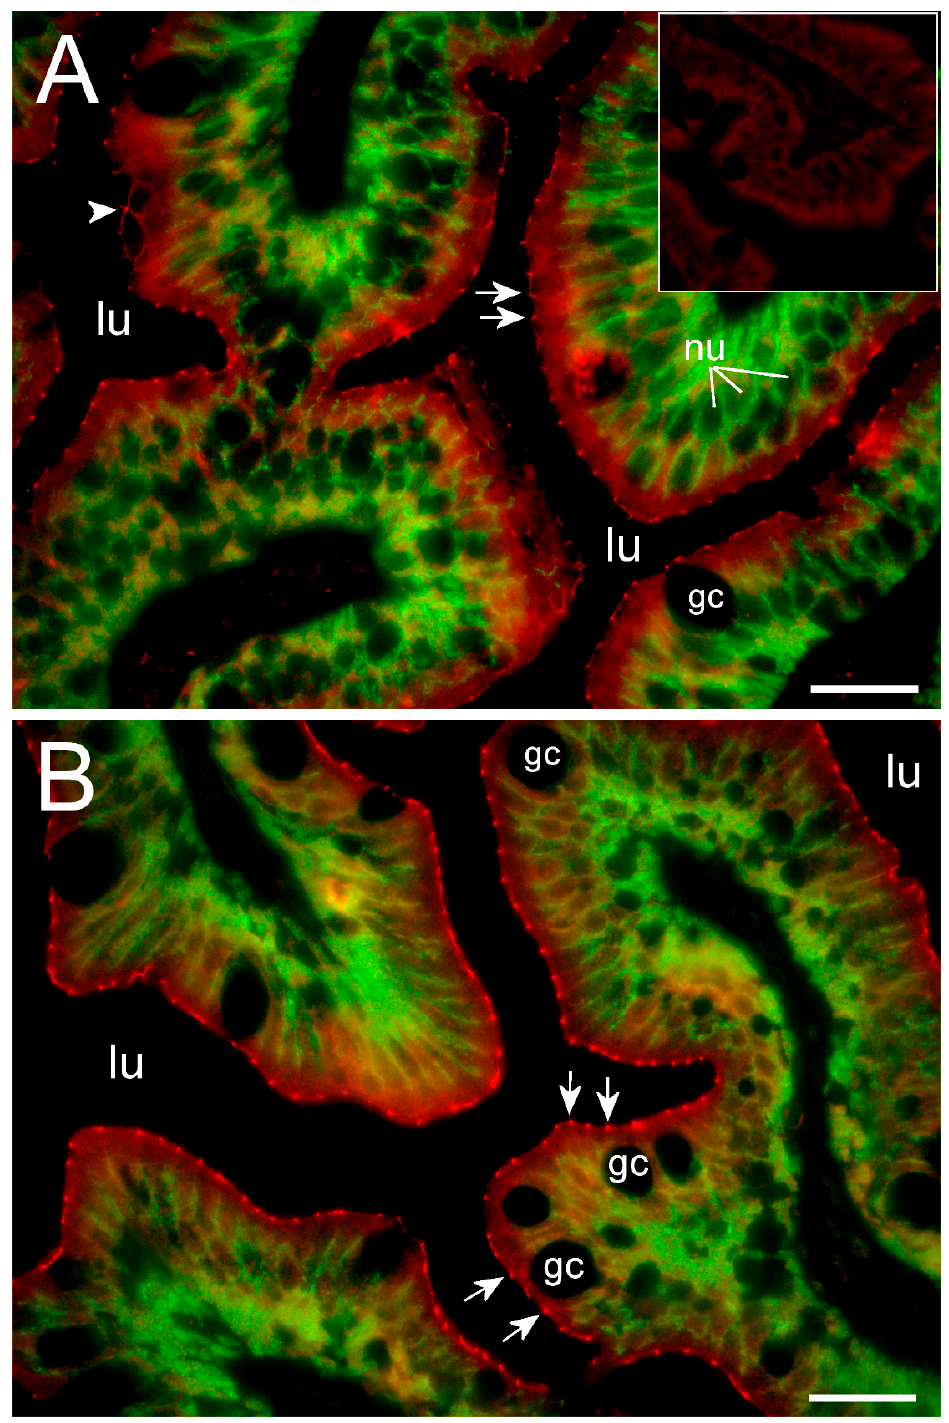
Figure 7. Immunofluorescence micrographs showing apical localization of Cldn15a (red in A ) and Cldn15b (red in B ) and basolateral localization of the Na + ,K + -ATPase alpha subunit (green) in SW-acclimated medaka middle intestine. The insert in the upper left corner shows control without primary antibodies. Images are at 1000× magnification. lu = lumen, gc = goblet cell, nu = nuclei; arrows point to “hot spots” in the tight junction zones; Size bars indicate 20 μ m.